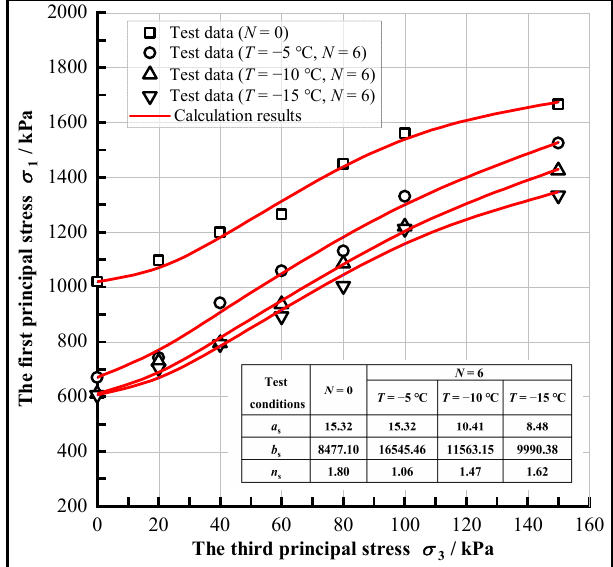
Figure 6. The test and calculation results of σ 1 vs. σ 3 of CIL.